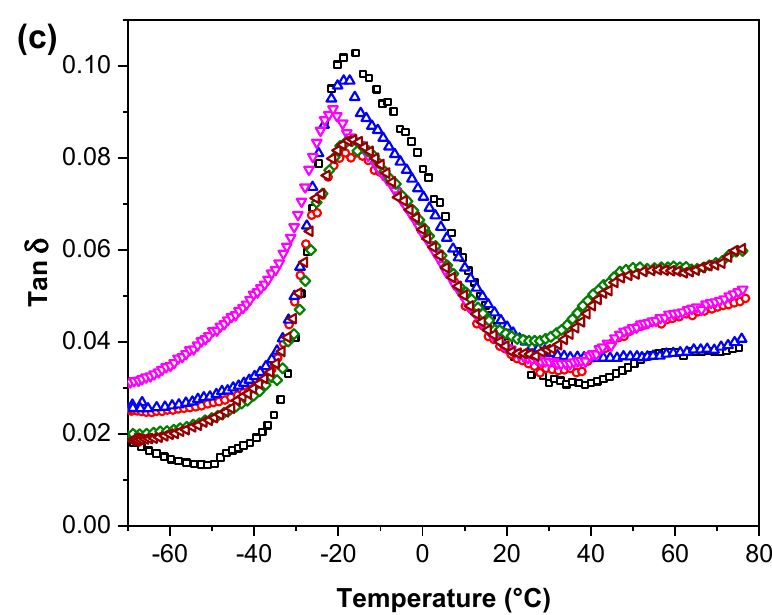
Figure 4. ( a ) The storage modulus E’; ( b ) the loss modulus E’’ and ( c ) loss tangent tan δ curves of PBS and PBS/cellulose composites.